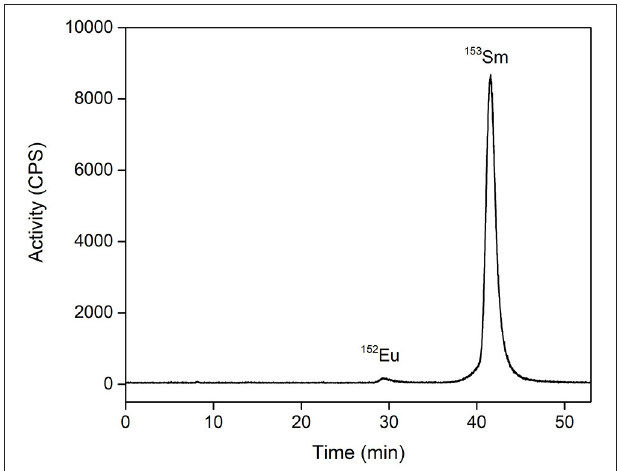
FIGURE 4 | Radio-chromatogram of 153 Eu/ 153 Sm separation on a strong cation exchange column using α -HIBA. Flow rate: 1 mL/min. The feed solution was spiked with 152 Eu tracers to enable detection of the Eu 3 +